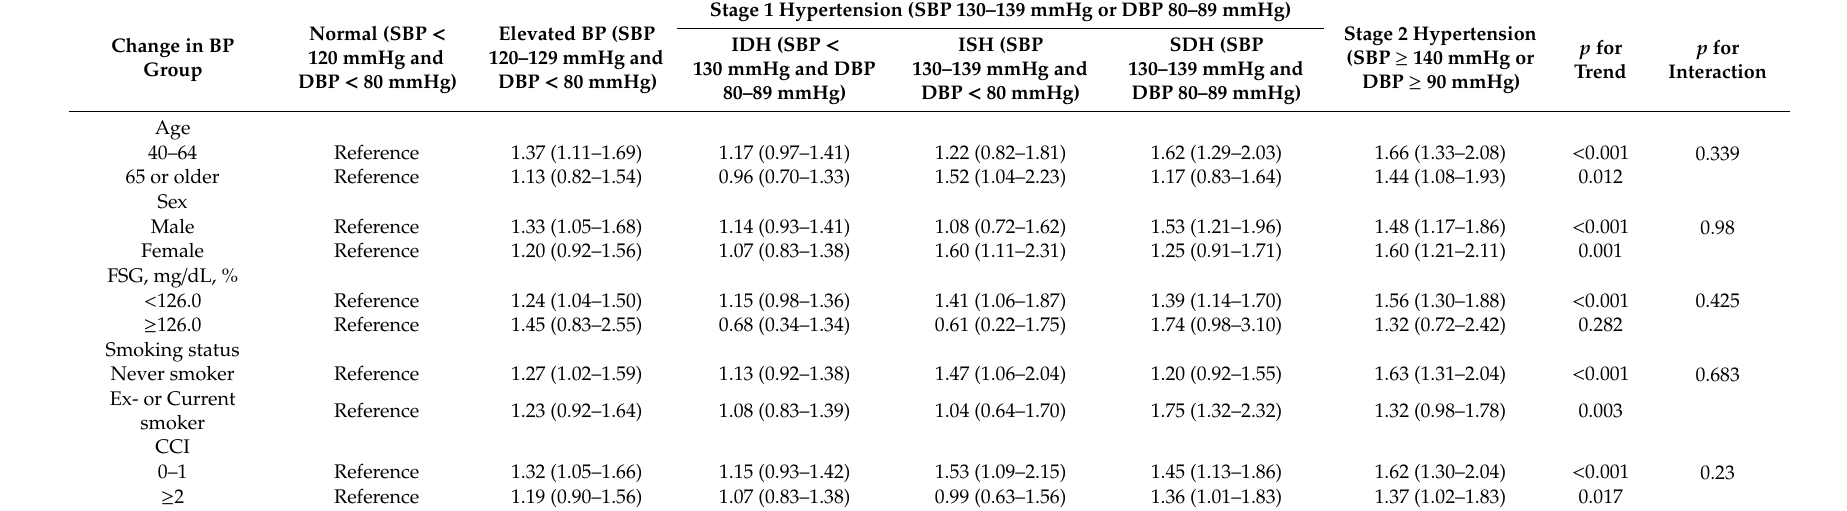
Table 5. Subgroup analysis of associations between change in blood pressure and risk of cardiovascular disease